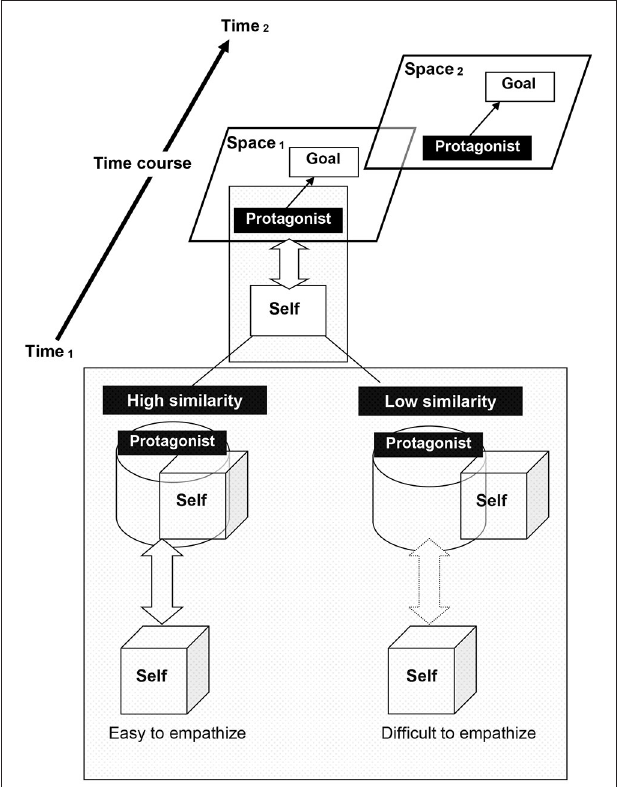
FIGURE 1 | Reader-protagonist interaction model . “Self” corresponds to “reader” or “listener” during discourse comprehension. The more the characteristics between self and story protagonists or characters overlap, the greater the